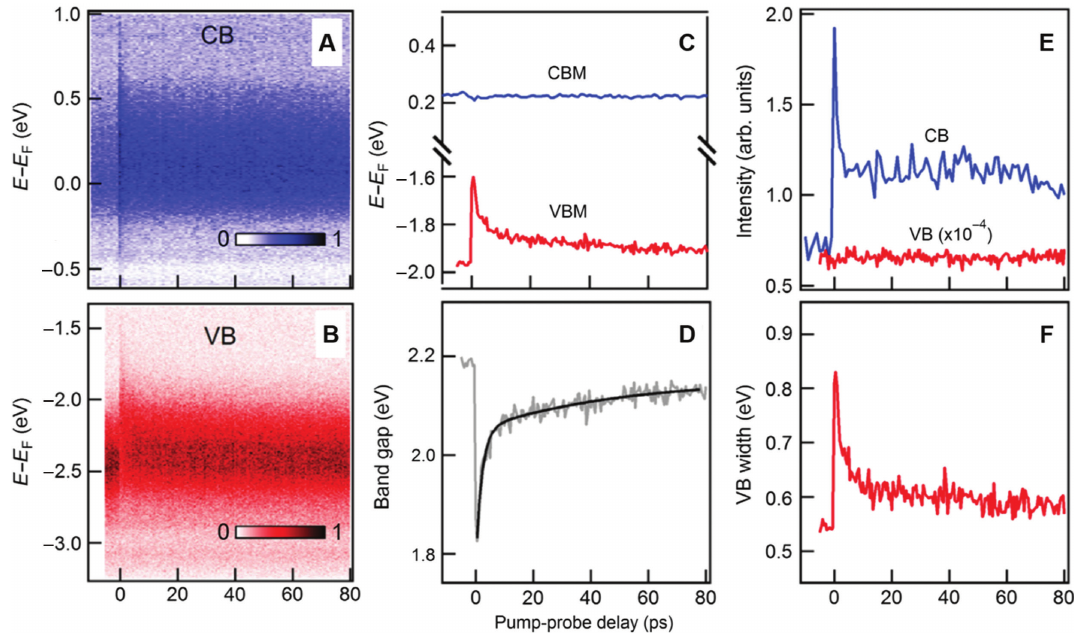
. 2 (gray) with bi-exponential g